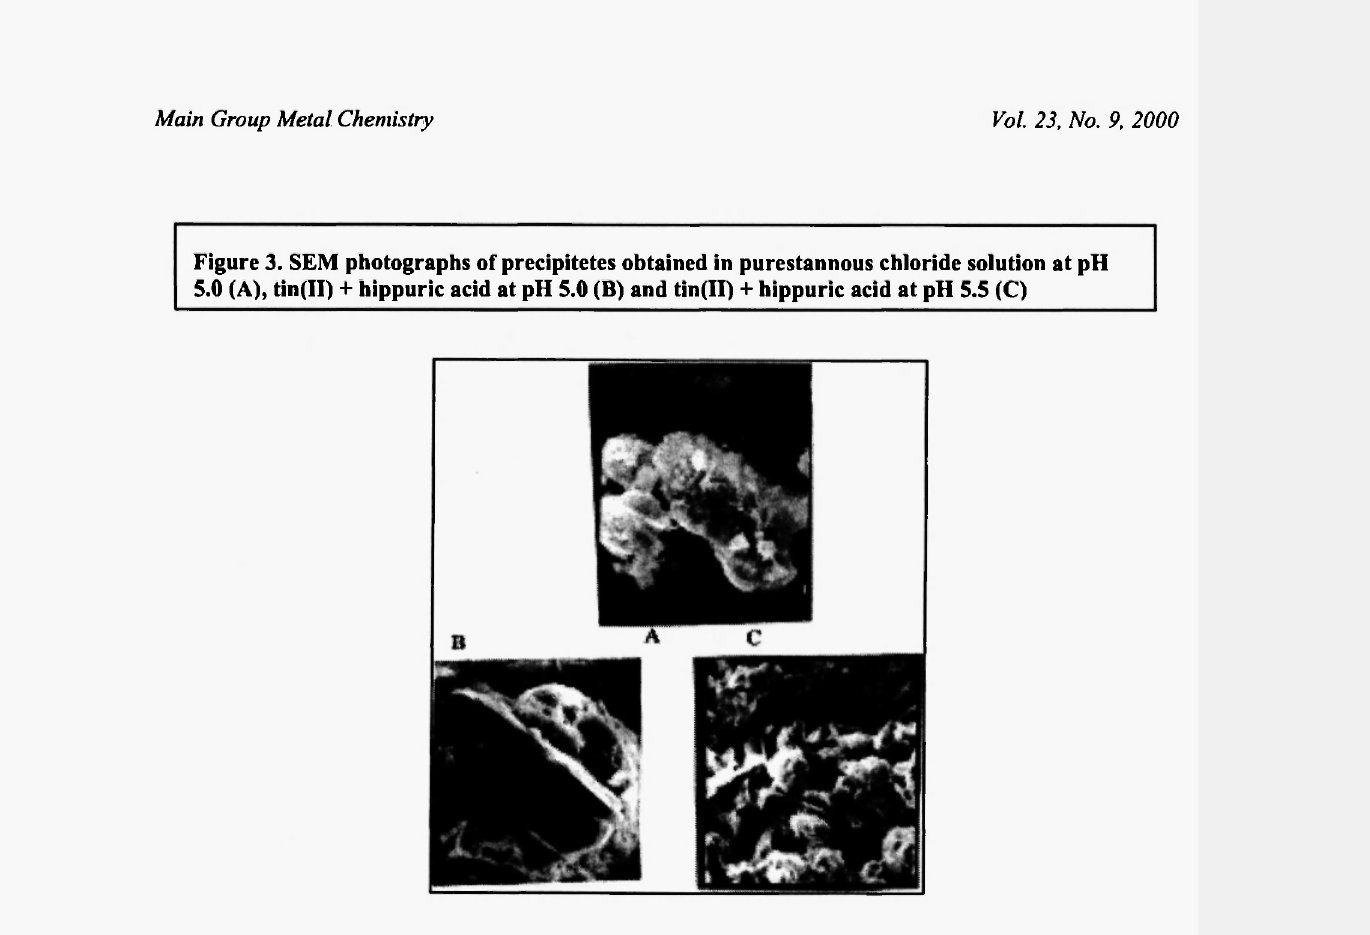
Figure 3. SEM photographs of precipitetes obtained in purestannous chloride solution at